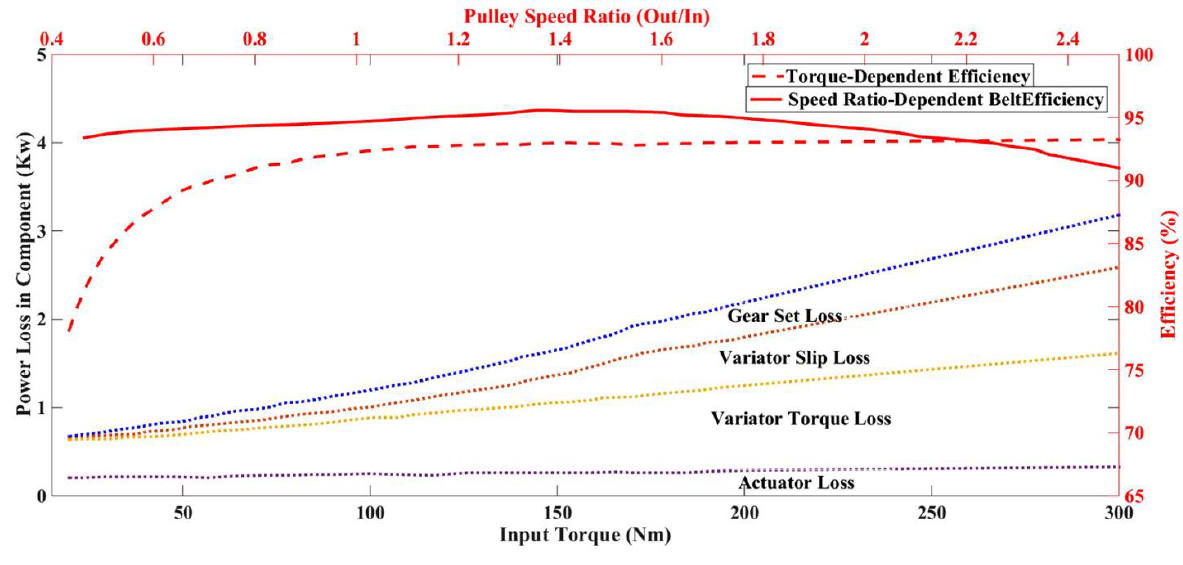
Figure 11. The variation of the losses and efficiency in CVT [154].